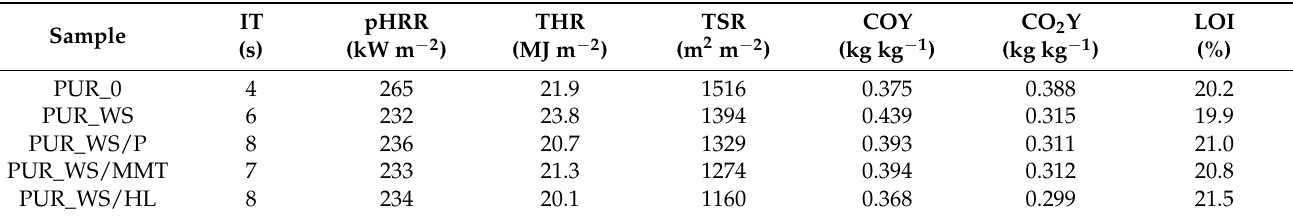
Table 3. The results of the cone calorimeter